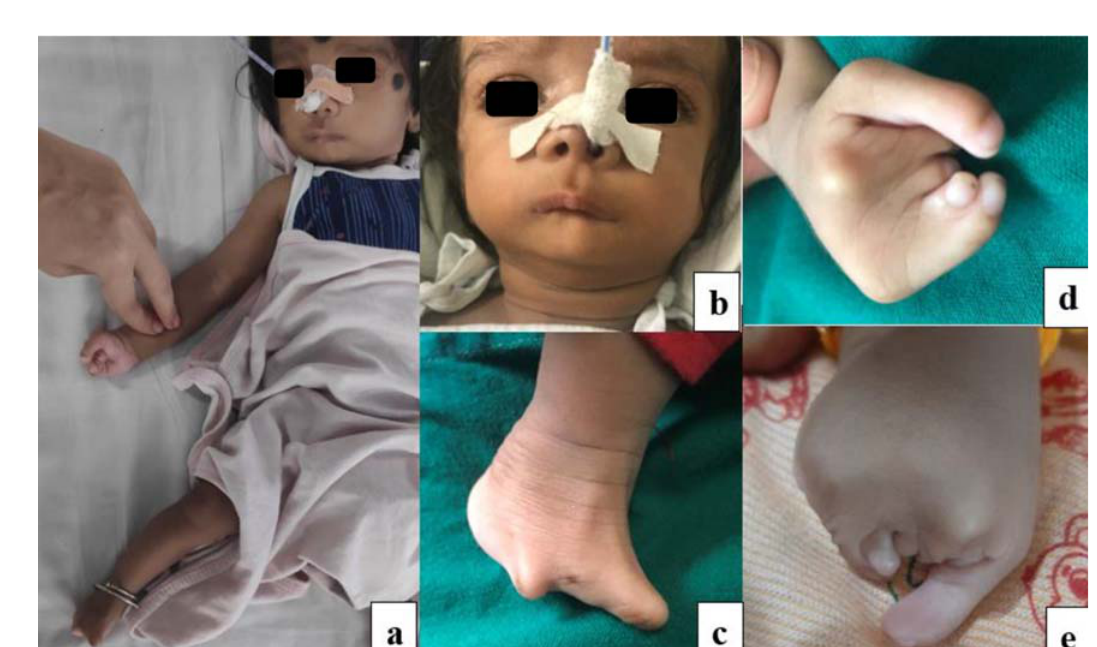
Fig. 1. (a) Frontal pro fi le of patient. (b) Frontal facial pro fi le. (c) Hypodactylomelia of right foot with absent metatarsals and phalanges. (d,e) Morphological features showing anonychia of the distal phalanges and hypoplasia of the distal hand